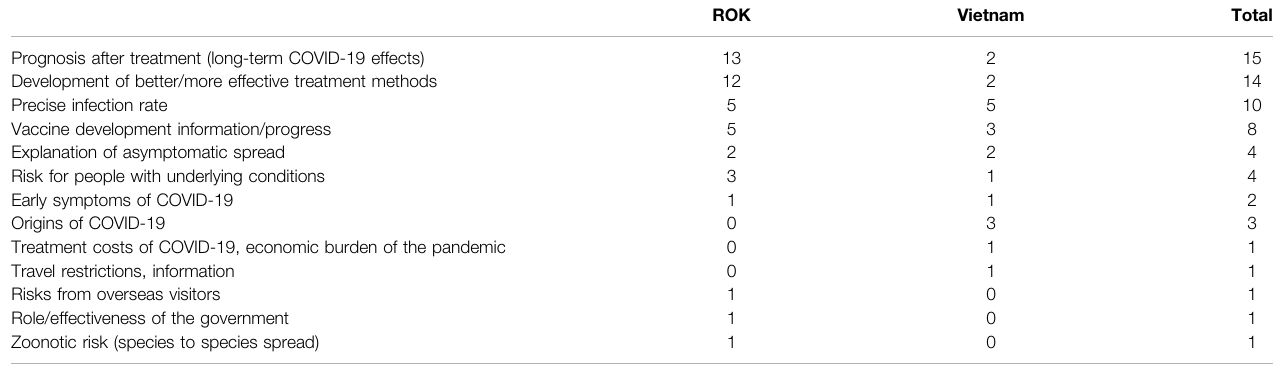
TABLE 6 | Topics of information insuf fi ciency in the RoK and Vietnam during COVID-19.